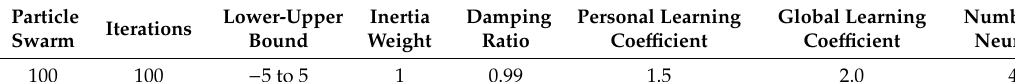
Table 1. PSO-ANN parameters.